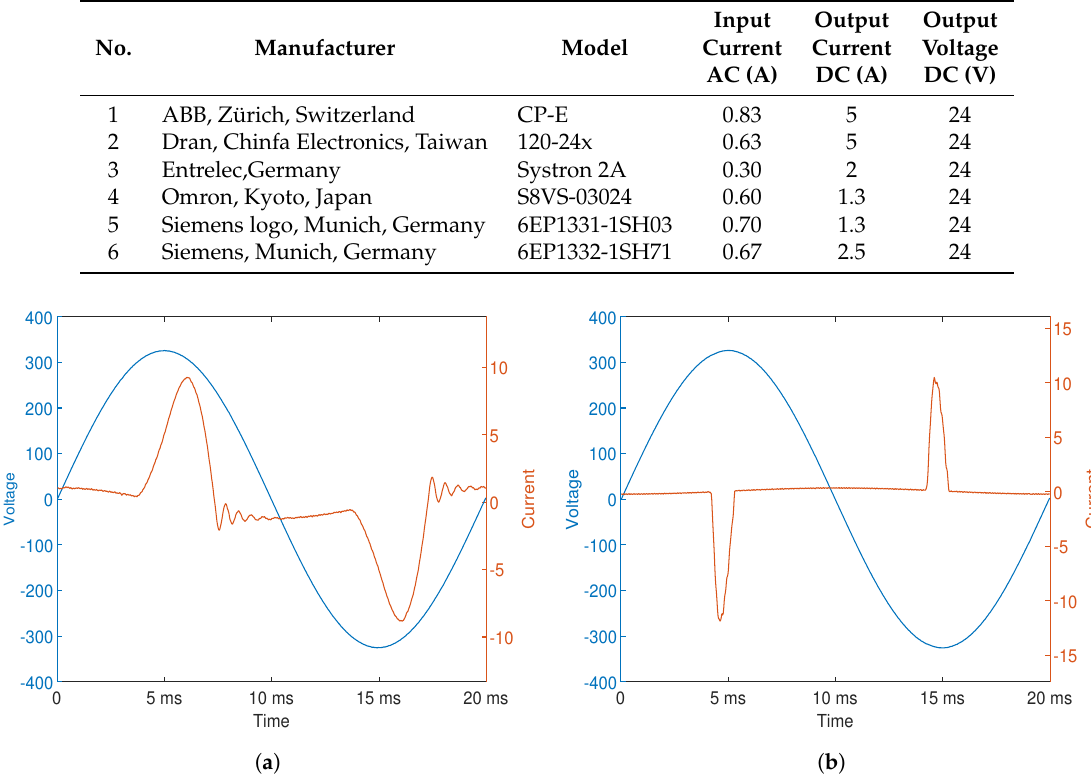
Table 1. Switch-mode power supplies (SMPS) characteristics.